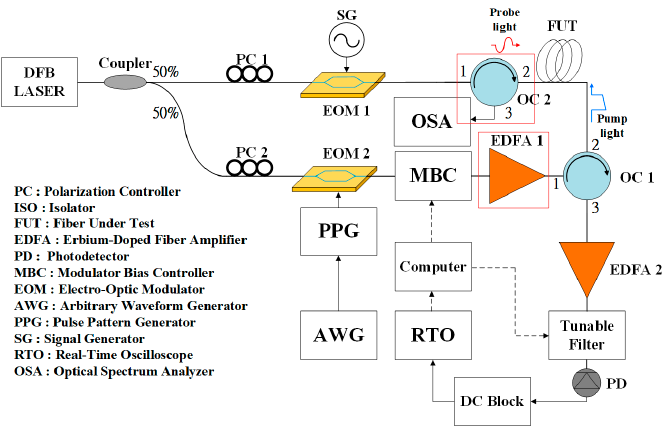
Figure 1. Hybrid system combining fiber grating and BOTDA system.